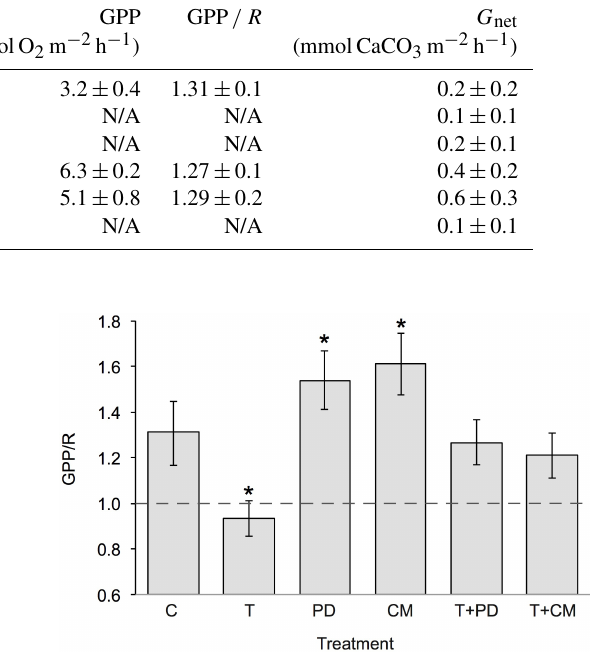
Figure 6. Ratios of sediment gross primary production (12h) to respiration (24h; GPP /R ) in response to warming ( + 2.4 ◦ C) and each OM treatment (phytodetritus and coral mucus). Control ( C ; n = 9) and warming ( T ; n = 7) treatments are averaged over all four incubations and the replicate chambers therein, while phytodetri- tus (PD), coral mucus (CM), and combination ( T + PD, T + CM) treatments are averaged over the two incubations (and replicate chambers therein) in which each respective OM treatment was used ( n = 4). Dashed grey line represents the divide between net het- erotrophy and net autotrophy (GPP /R = 1), while the * indicates if the presented value is significantly different the